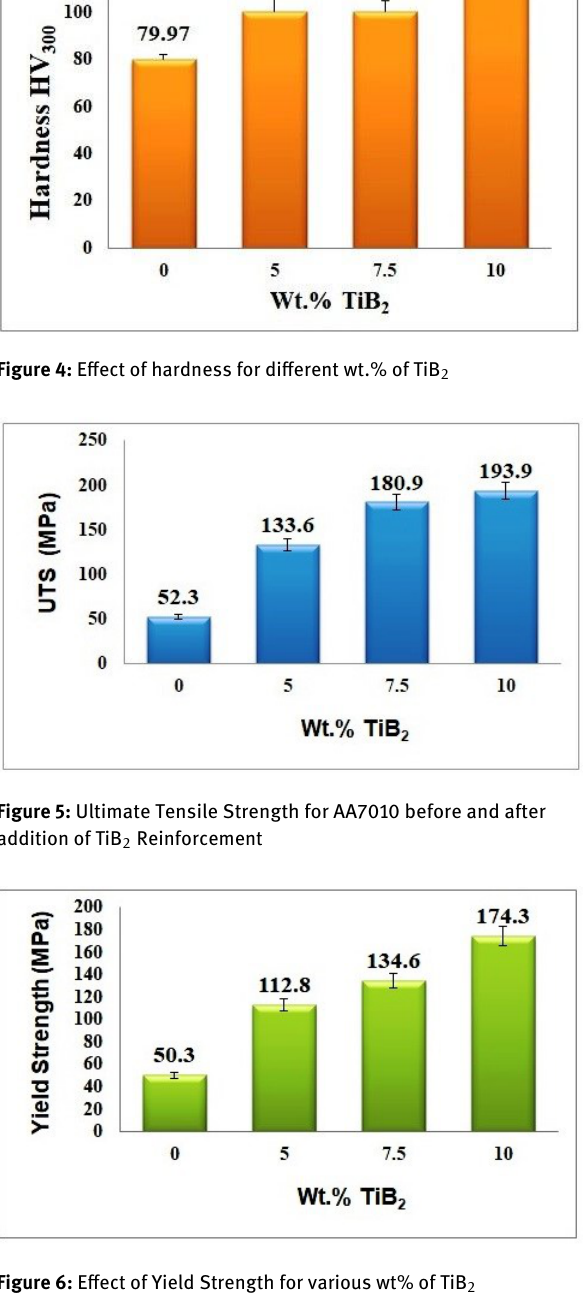
tensile loading the interaction between strong TiB ulates and dislocations impedes the cracks propagation leading to increase of tensile properties. According to well known Hall-Patch relationship, grain refined in-situ TiB particulates increase the area to resist the tensile loading and improves the strength of the composite. Owing to the existence of hard particulate reinforcement with a signifi-